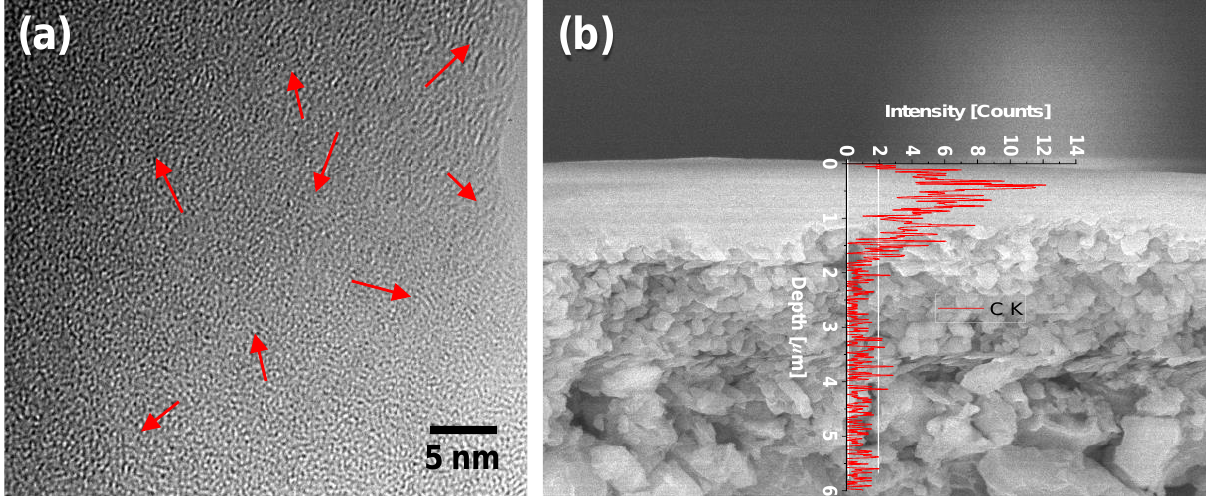
Figure 21. ( a ) TEM image of the carbon–ceramic sample pyrolyzed at 850 °C. Arrows point to short patterns representing the ordered structures of the graphite-like carbon. ( b ) SEM image of a SiO 2 -ZrO 2 -polybenzoxazine-derived carbon-SiO 2 -ZrO 2 membrane fabricated at 850 °C. Adapted from [110].